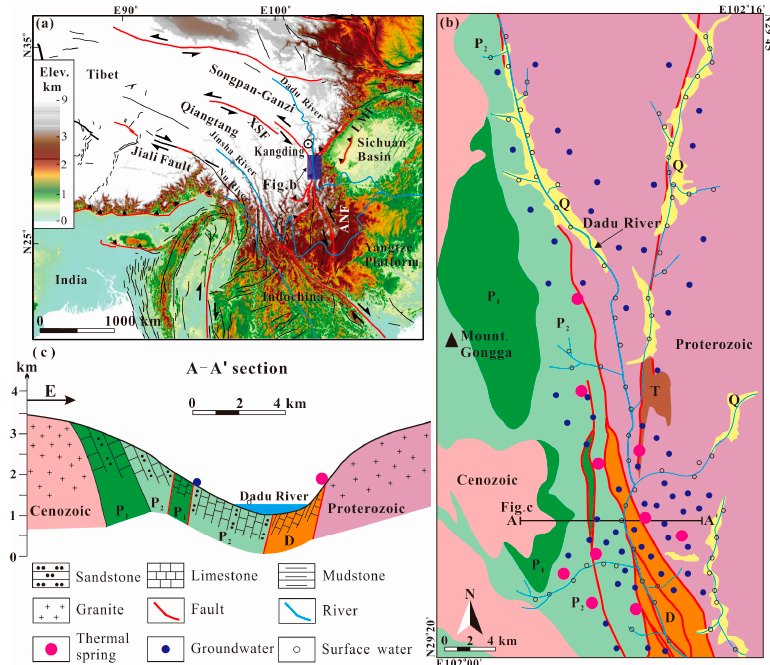
Figure 1. ( a ) Topography of Southwestern China; ( b ) geological map and ( c ) cross section of Kangding County. D: Devonian, P 1 : Lower Permian, P 2 : Upper Permian, T: Triassic, Q: Quaternary.